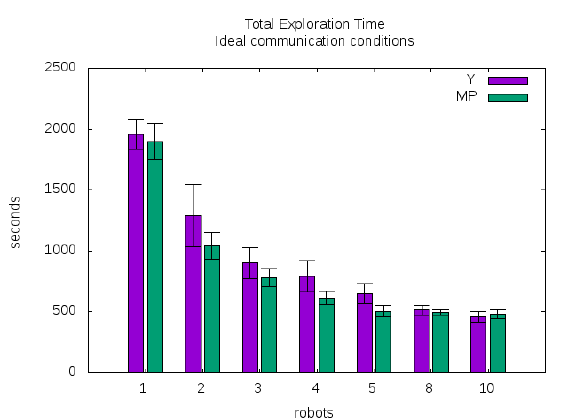
Figure 13. Total exploration time (TT) under ideal communication conditions. Both approaches show a decreasing trend of TT as the fleet size increase. Nevertheless, the fact that the performance improvements are decreasing suppose the existence of a limit on the benefit from robots adding.